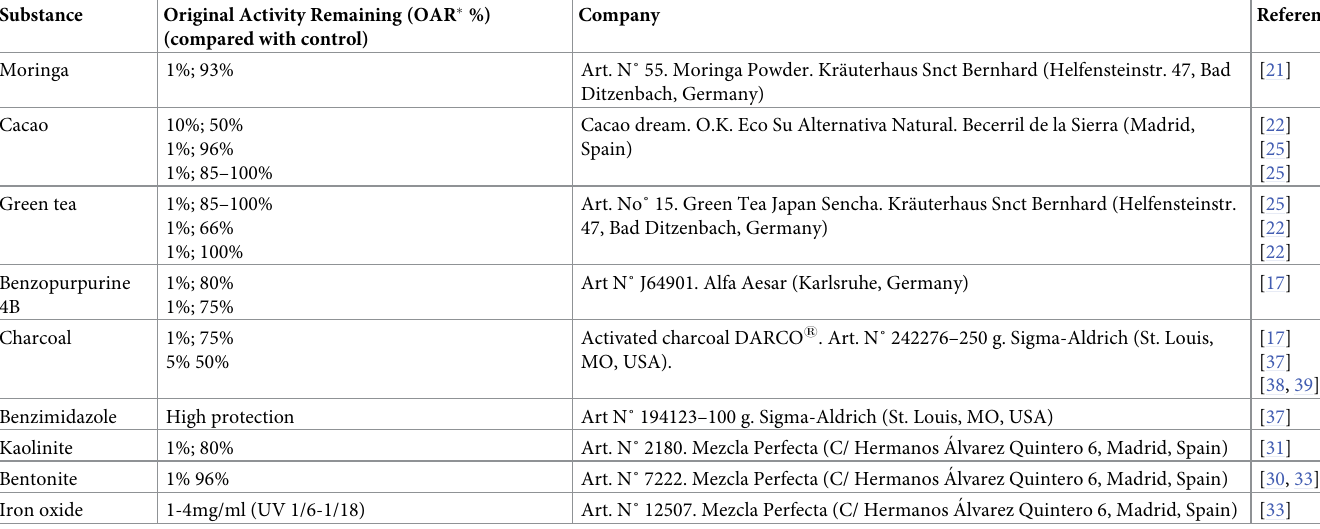
Table 1. Natural substances that were assayed as UV-protectives under laboratory conditions. Substance Original Activity Remaining (OAR � %) (compared with control)